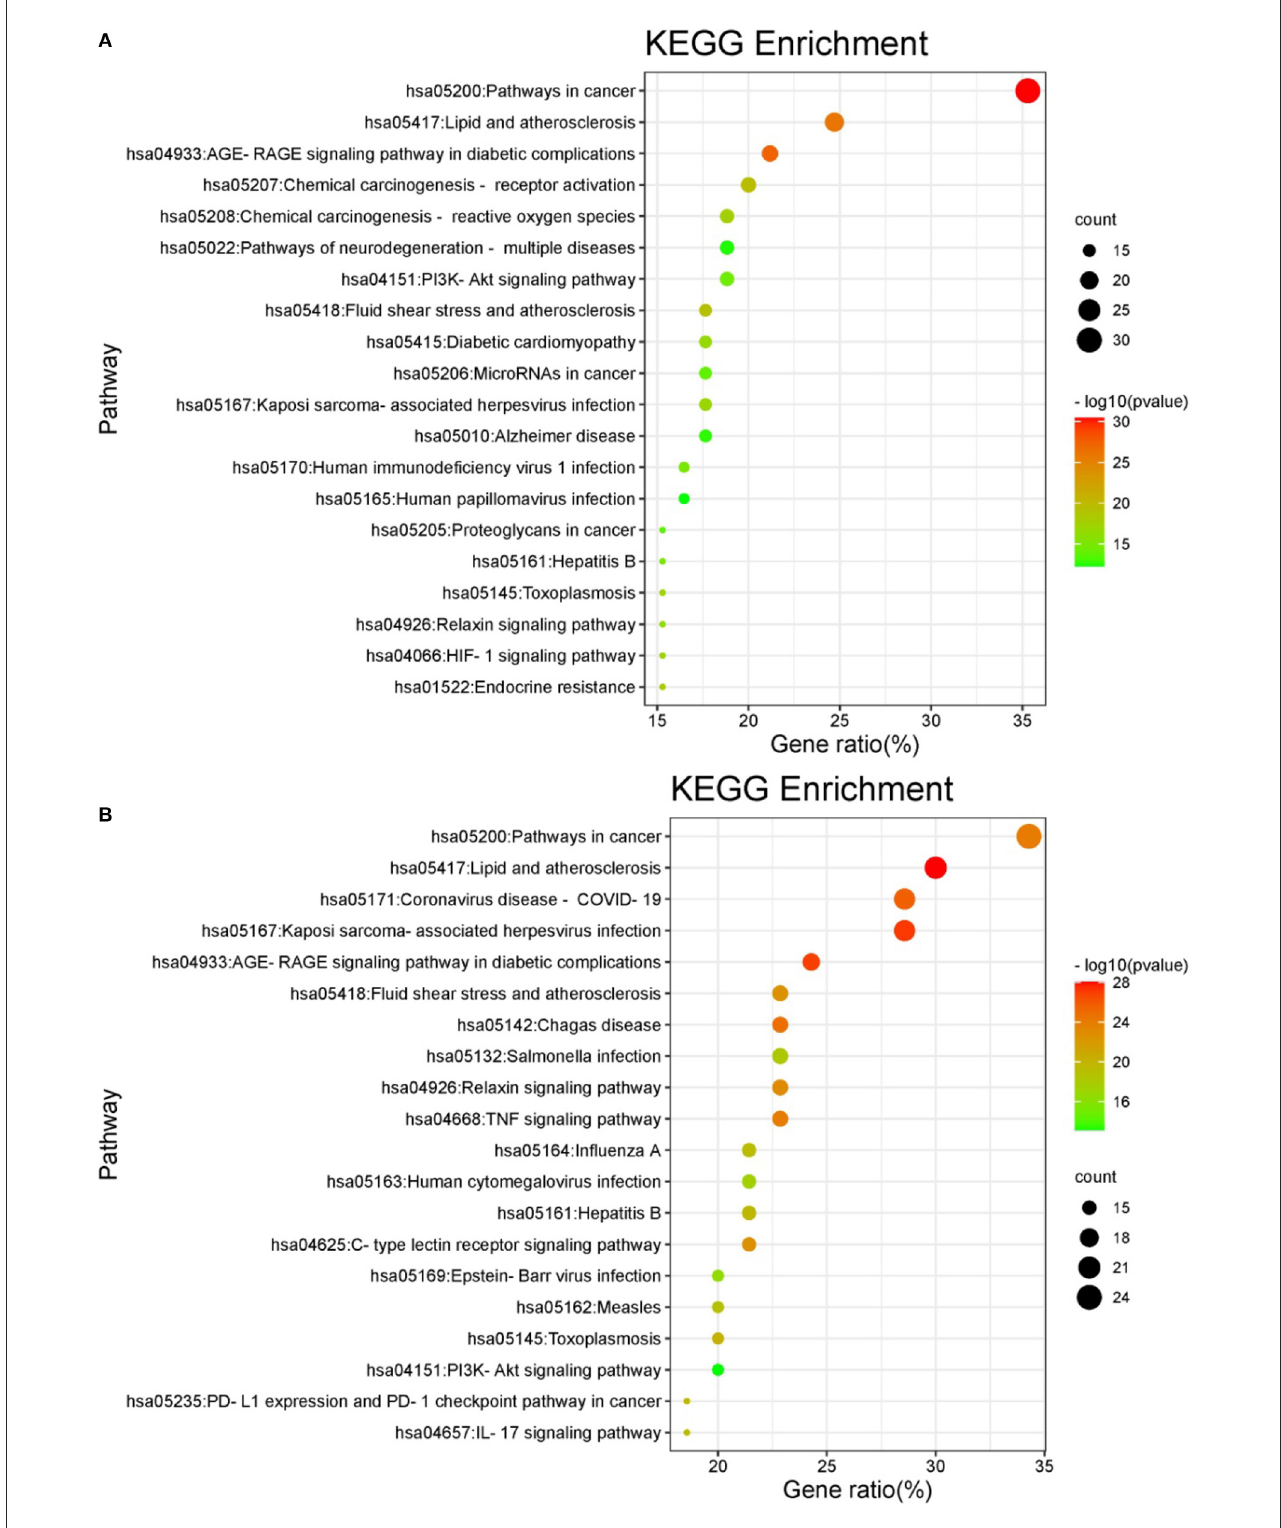
FIGURE7 KEGG pathway enrichment of oxidative damage (A) /inflammation (B) .